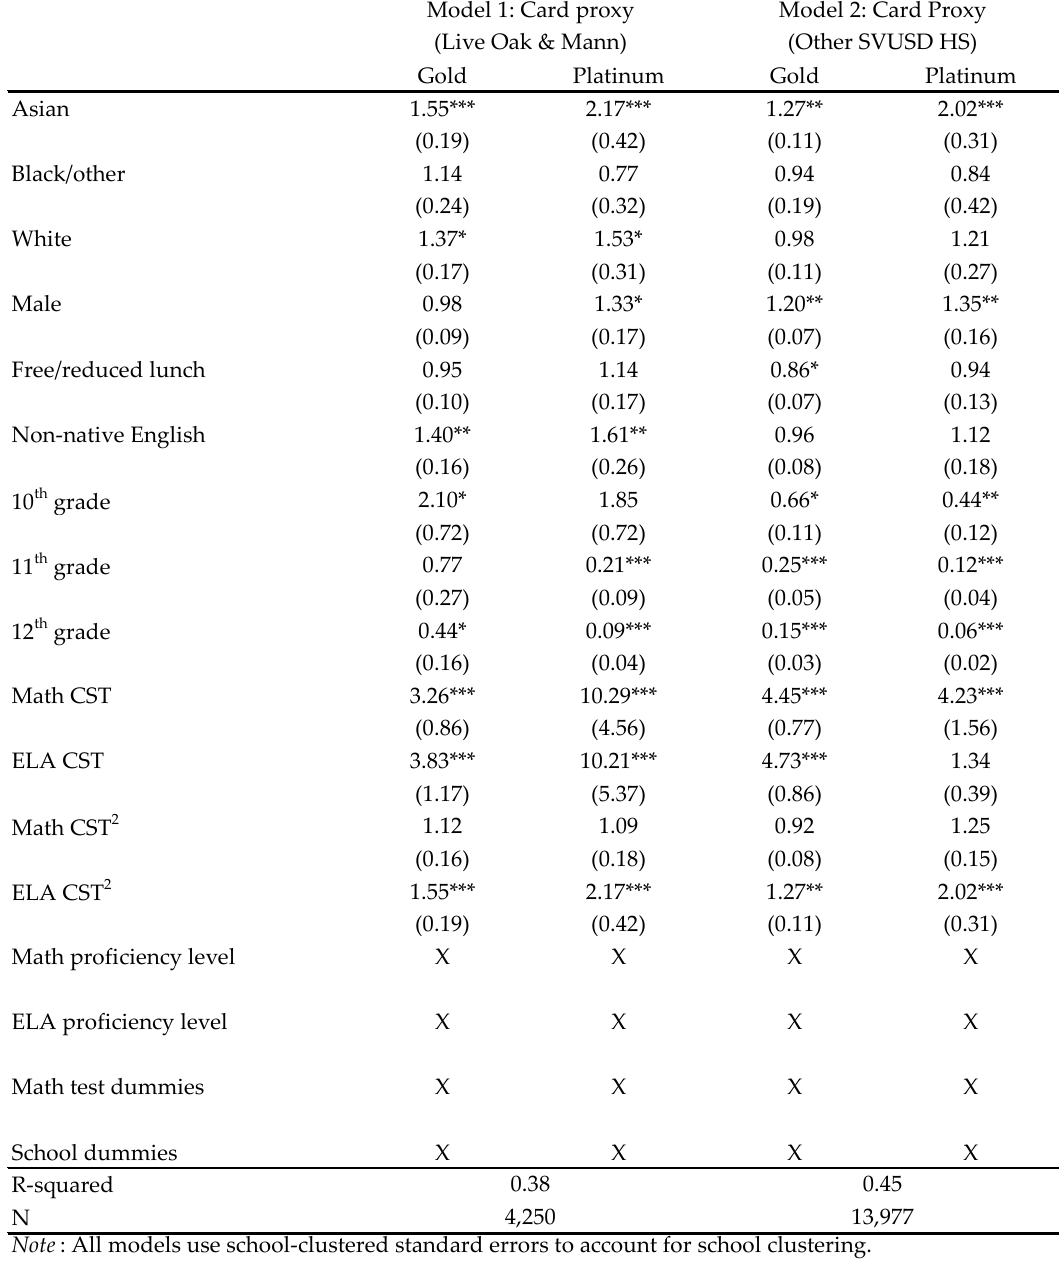
Table S2: Multinomial logistic regression – odds of meeting gold or platinum card proxy (all 2012 Sudden Valley Unified School District high school